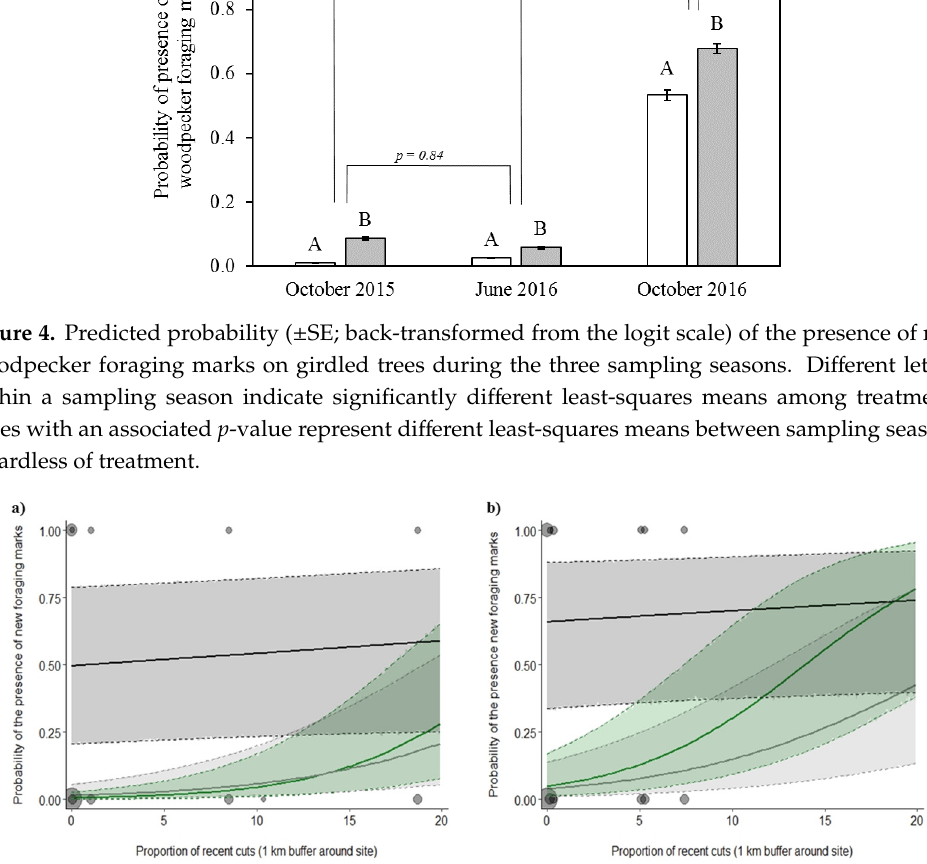
Figure 5. Projected probability of presence of new woodpecker foraging marks ( ± 95% CI) on girdled trees sampled in October 2015 (green lines), June 2016 (gray lines), and October 2016 (black lines) based on the proportion of recent cuts 1 km around sites for ( a ) uniform and ( b ) clustered treatments. Gray dots represent the distribution of raw data; the size of the dots is related to the number of observations; darker gray dots are superimposed data.